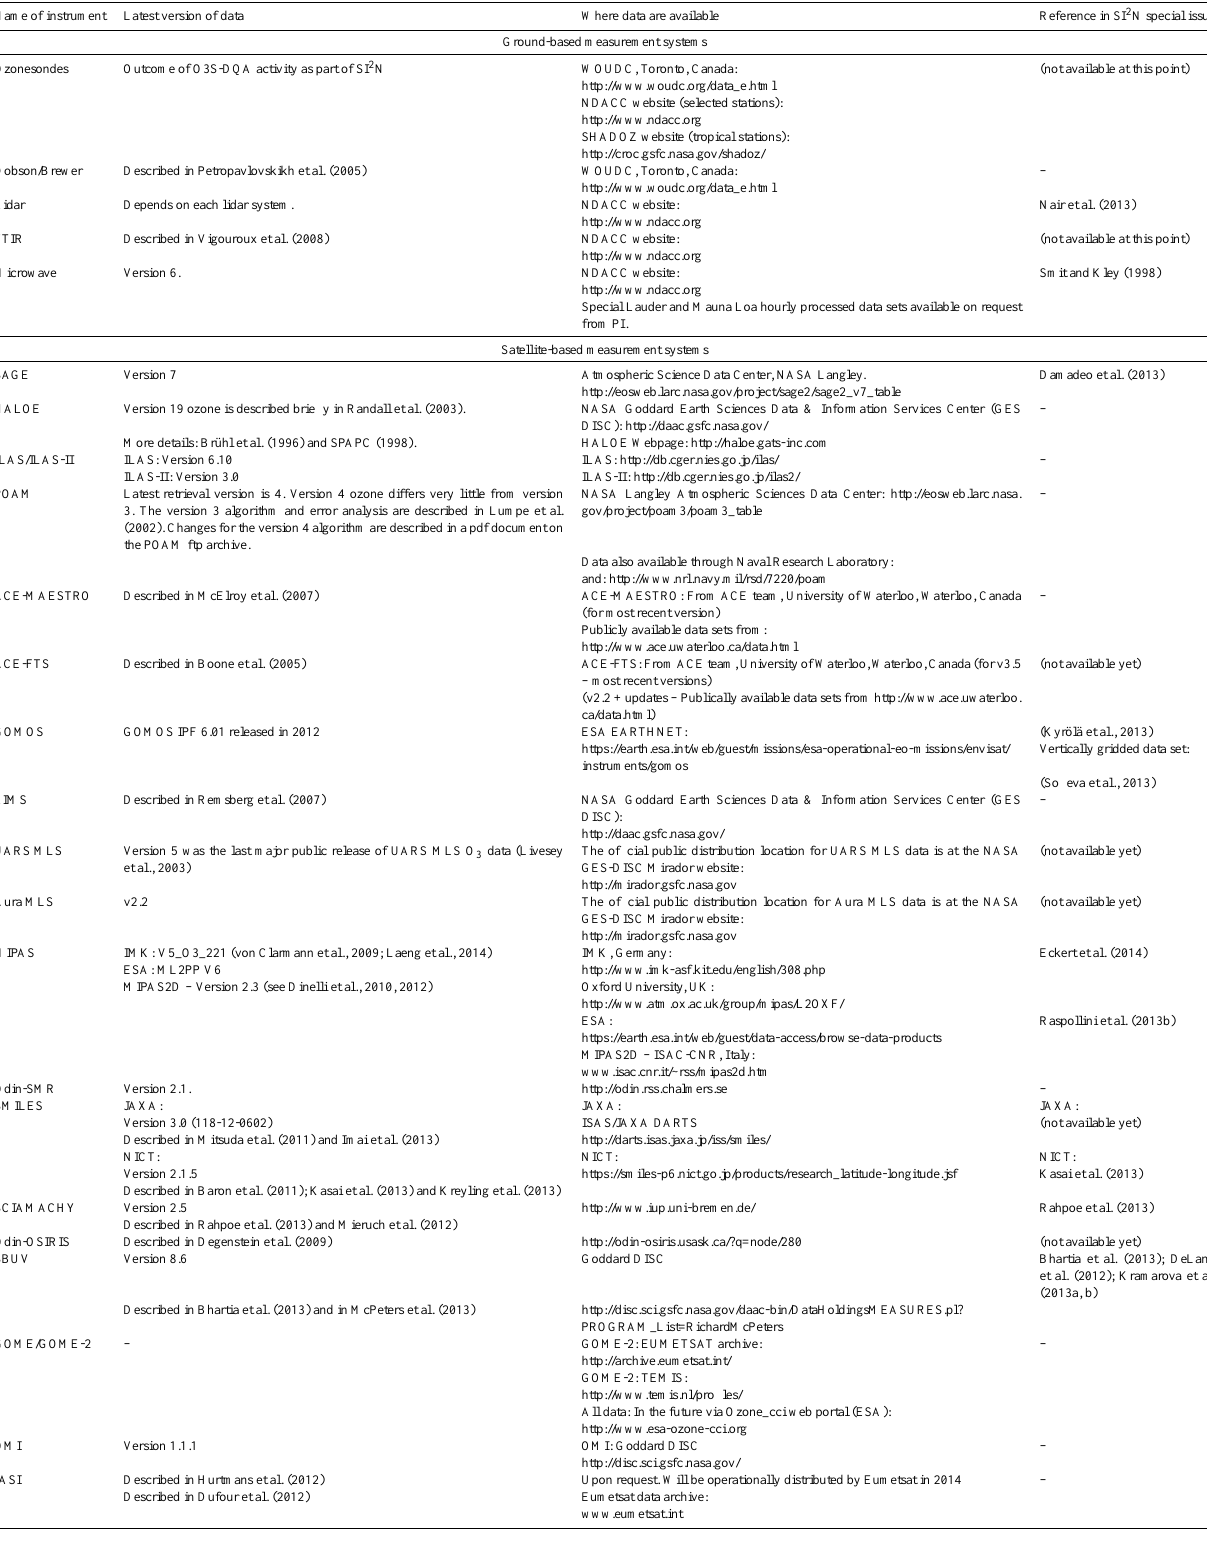
Table 1d. Summary of the latest data version, URLs where data are available, and information about references in the SI 2 N special issue for the five ground-based measurement systems and all described satellite measurement